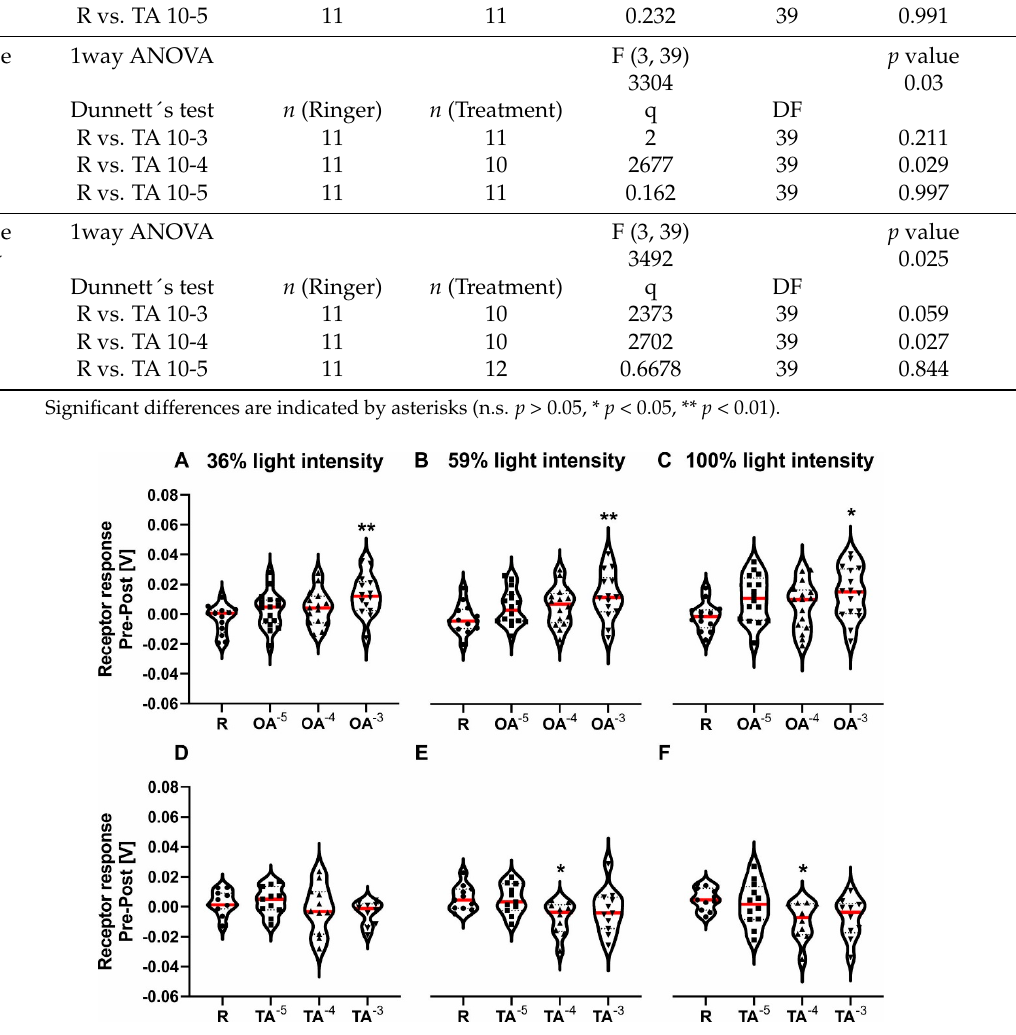
Figure 1. ERG − amplitude receptor response pre-post for three concentrations of octopamine (x-axis in A – C ) and three concentrations of tyramine (x-axis in D – F ) and the respective Ringer control (R). The different light intensities are shown at the top. The median is marked in red. Dots, squares, upper triangles and lower triangles represent individual data points for Ringer, OA/TA 10 − 5 mol/L, OA/TA 10 − 4 mol/L, OA/TA 10 − 3 mol/L, respectively. ( A – C ): Pre-post response after OA and Ringer were applied using 36%, 59% and 100% light intensity filters for A, B, and C respectively. A significant overall effect was found for all three light intensities. OA 10 − 3 mol/L significantly increased the amplitude (for statistics, see Table 2). ( D – F ): Pre-post responses after TA or Ringer were applied using 36%, 59% and 100% light intensity filters for D, E, and F respectively. No significant differences were found for the 36% light intensity filter. A significant overall effect was found for 59% and 100% light intensity. TA 10 − 4 mol/L significantly decreased the amplitude (for statistics, see Table 2). Significant differences between Ringer and either treatment are indicated by asterisks (* p < 0.05, ** p <